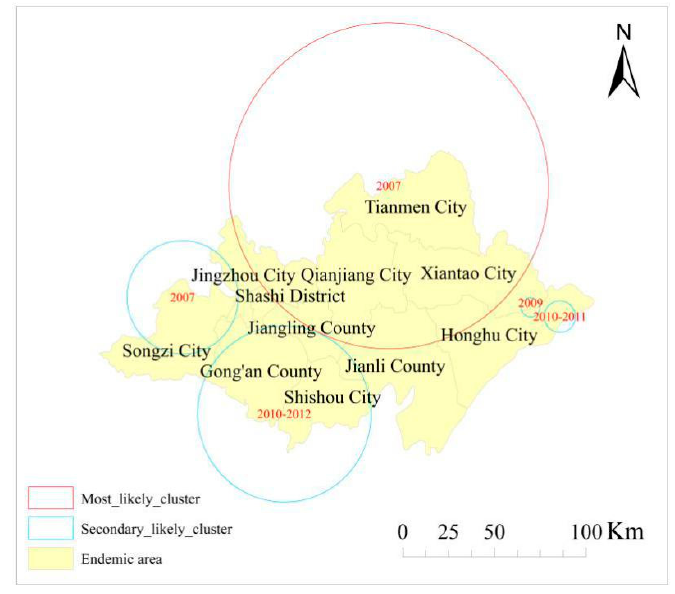
Figure 3. Space–time clusters detected using the Space–Time Permutation model. Table 2. Space–time analysis of clusters with large populations of schistosomiasis infections using Kulldorff’s spatial scan statistic.